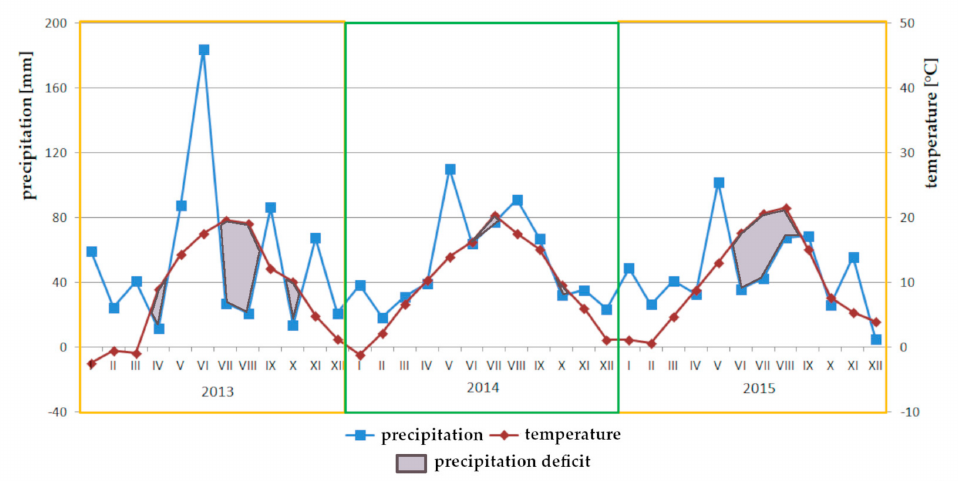
Figure 1. A Gaussen–Walter climatic diagram with Łukasiewicz [34] modification presenting con- ditions during three consecutive years of study. The values of precipitation and temperature are presented as the monthly sum and mean, respectively. The parts of the graph where the precipitation line is below the temperature are considered as precipitation deficit